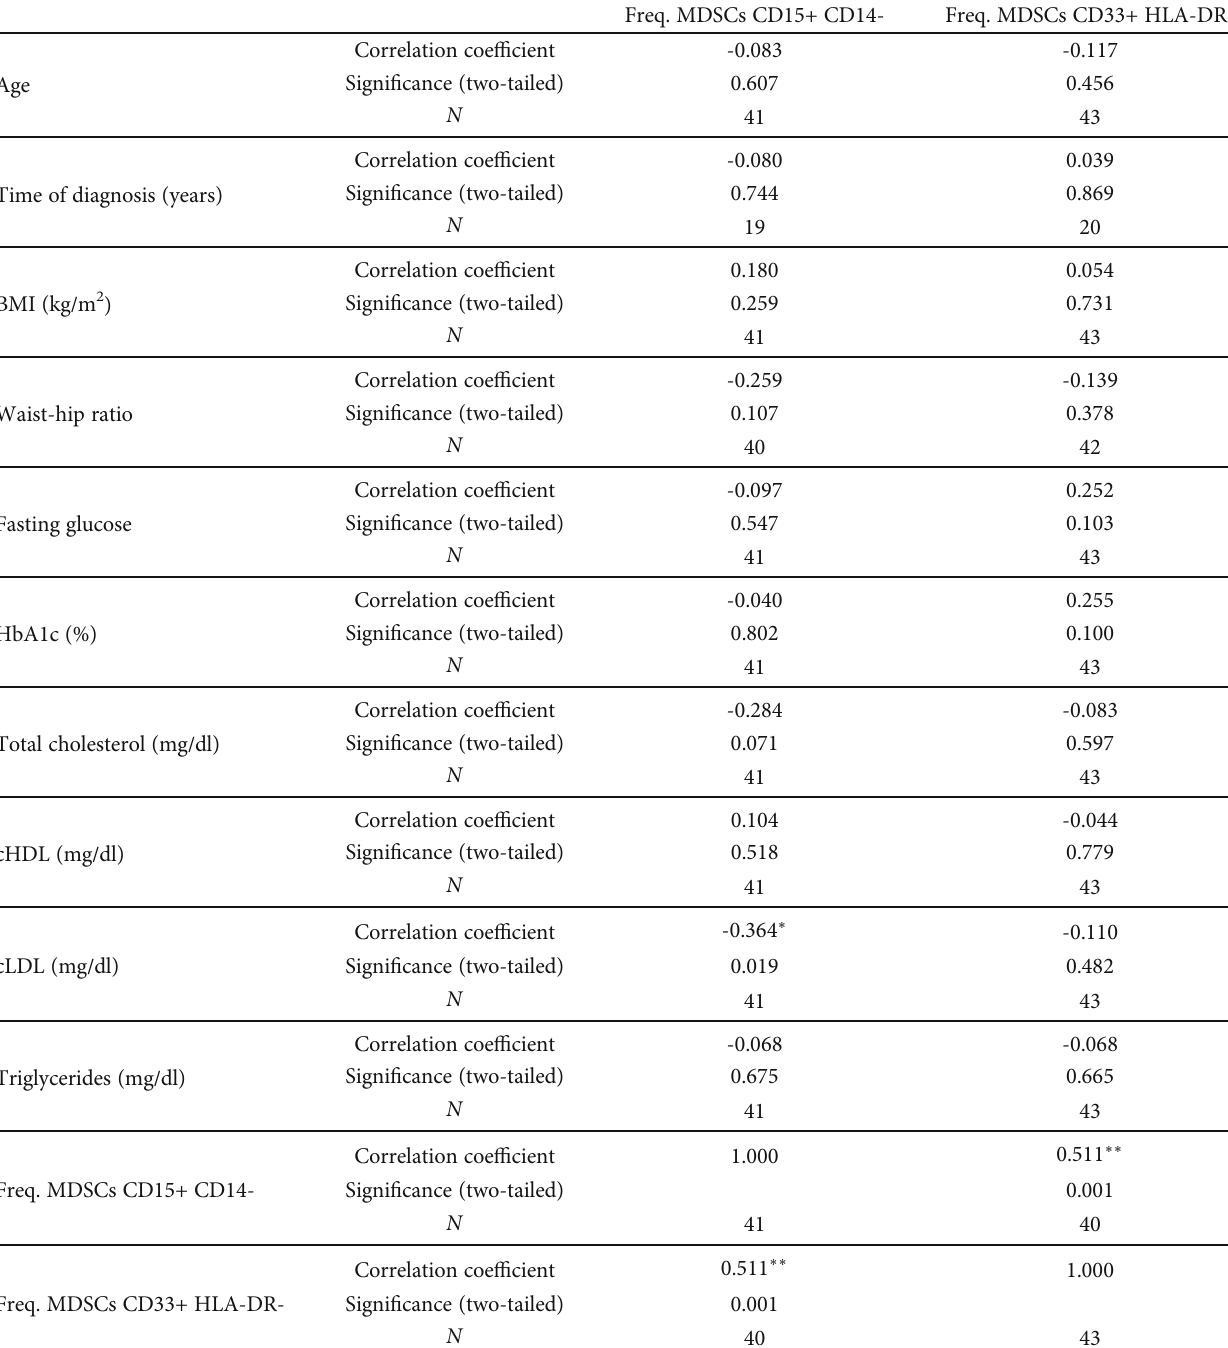
Table 3: Correlation analysis of variables with the frequency of MDSCs #